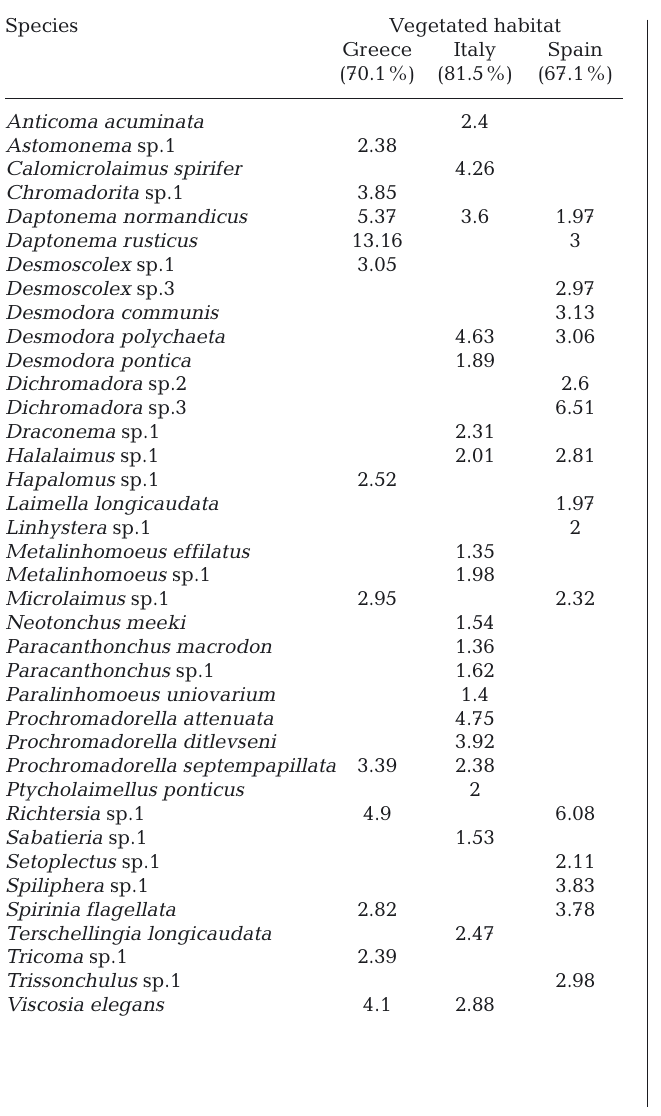
Table 5. SIMPER analysis showing nematode species contributing (cut-off 50%) to turnover diversity between control and impact sites in vegetated and non-vegetated habitats in Greece, Italy and Spain. Values are percentage contributions of the i th species to